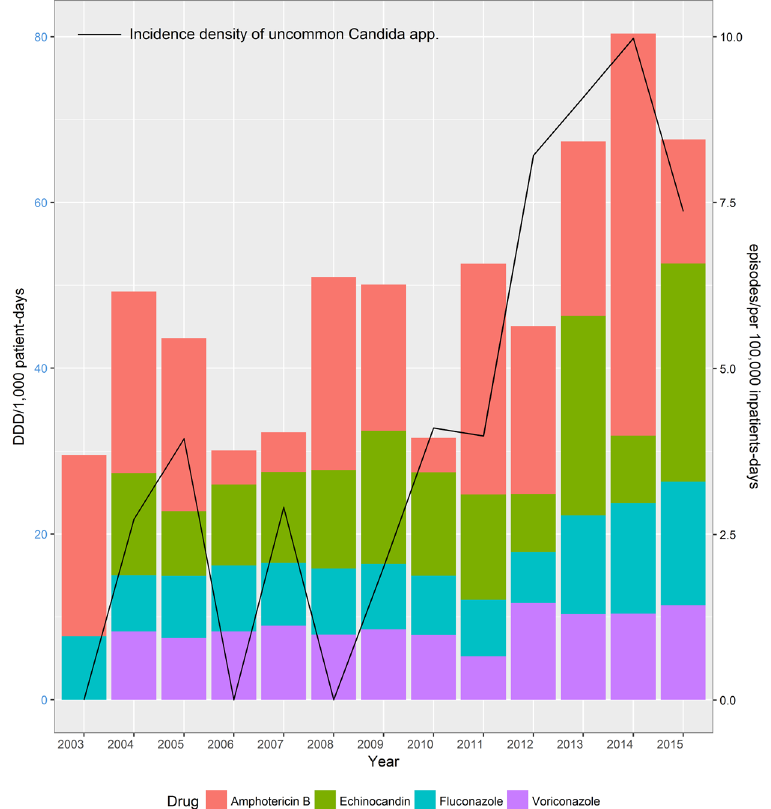
Figure 1. Increasing incidence density and proportion relative to all episodes of invasive candidiasis caused by uncommon Candida species and increasing annual use of overall antifungal drugs in Chang Gung Memorial Hospital, Taiwan, R.O.C. January 2003–December 2015. Spearman correlation coefficient r = 0.59, p = 0.033. DDD, defined